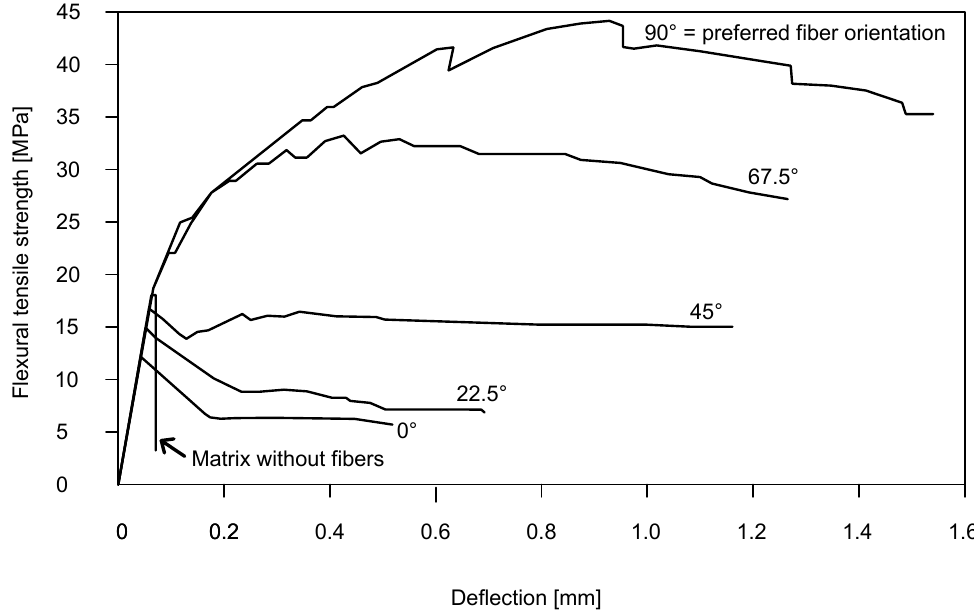
Figure 1. Effect of fibre orientation on the tensile strength of UHPC [1]. The preferred fibre orientation is parallel to the direction of tensile forces, which corresponds to the angle of 90 ◦